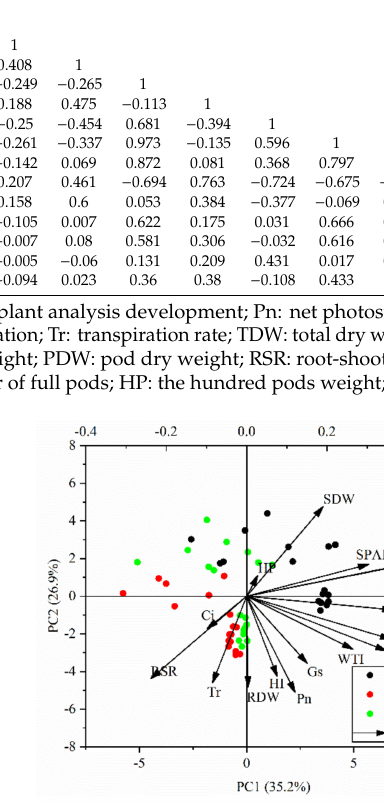
Figure 4. Biplot from the principal component analysis (PCA) of three peanut ecotypes and 16 attributes. The first and second components account for 35.2% and 26.9% of the variation, respectively. Eigenvector plots can be interpreted as follows: (1) trait vectors with a narrow angle between them indicate that a positive correlation exists between the traits (the narrower the angle, the greater the correlation); (2) trait vectors perpendicular to each other indicate no correlation between the traits; and (3) trait vectors in opposing directions indicate that a negative correlation exists between the